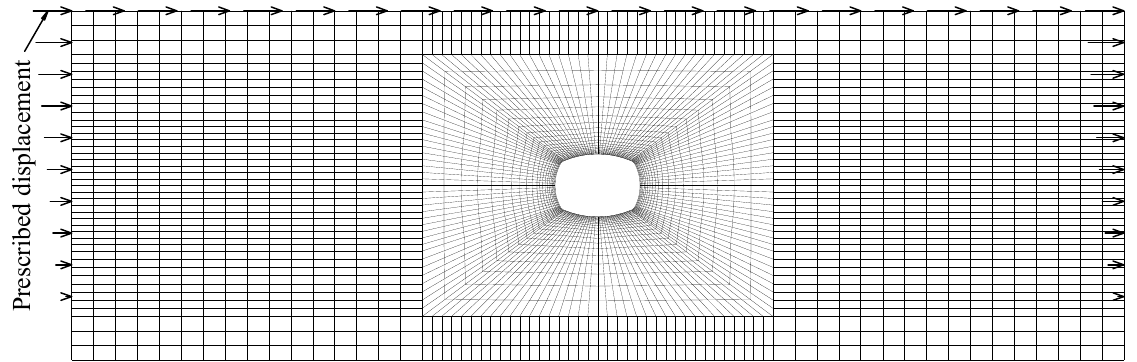
Figure 8. Geometry and quasi-static loading conditions in the numerical model of a sub-rectangular tunnel.